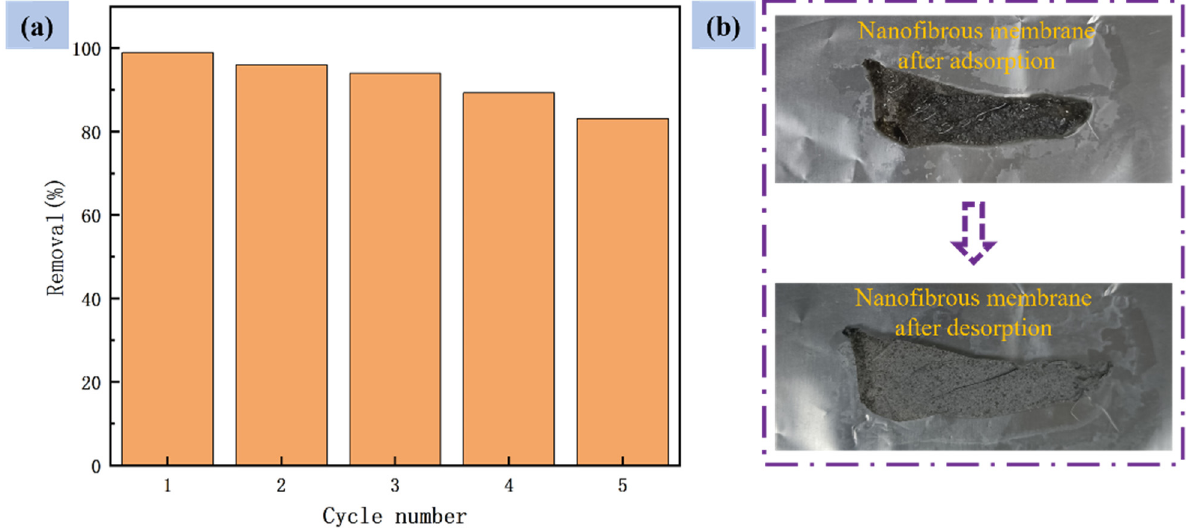
Figure 10. ( a ) Reusability of Cr(VI) from PVDF–2GO@GO nanofibrous membranes in cyclic adsorption–desorption test and ( b ) nanofibrous membranes after adsorption and desorption. Table 3. Comparison of adsorption performance of the PVDF–2GO@GO nanofibrous membranes with other adsorbents for Cr(VI).